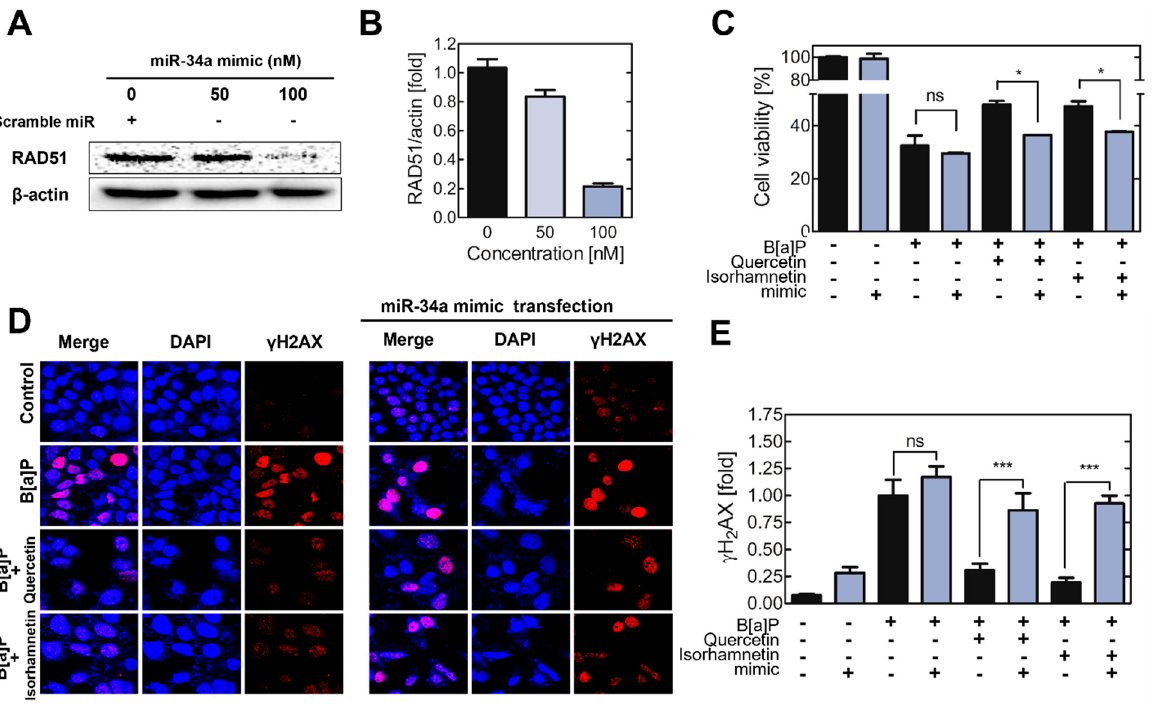
Figure 5. The effects of quercetin and isorhamnetin on cells transfected with a miR − 34a mimic. ( A ) The protein level of RAD51 in cells transfected with a miR − 34a mimic was assessed. ( B ) The relative RAD51 levels in variously treated cells are expressed as a bar graph. β − actin was used as an internal control in ( A , B ). ( C ) The viability of the cells transfected with the miR − 34a mimic was analyzed after they were co − treated with B[a]P and quercetin or isorhamnetin. ( D ) The expression pattern of γ H 2 AX in the cells transfected with the miR − 34a mimic was compared with that in non − transfected cells. ( E ) The fluorescence intensity from γ H 2 AX was calculated and expressed as a bar graph. * p < 0.05, *** p < 0.001, ns; not significant, C; control, Q; quercetin, I; isorhamnetin, B; B[a]P, m; mimic transfection.